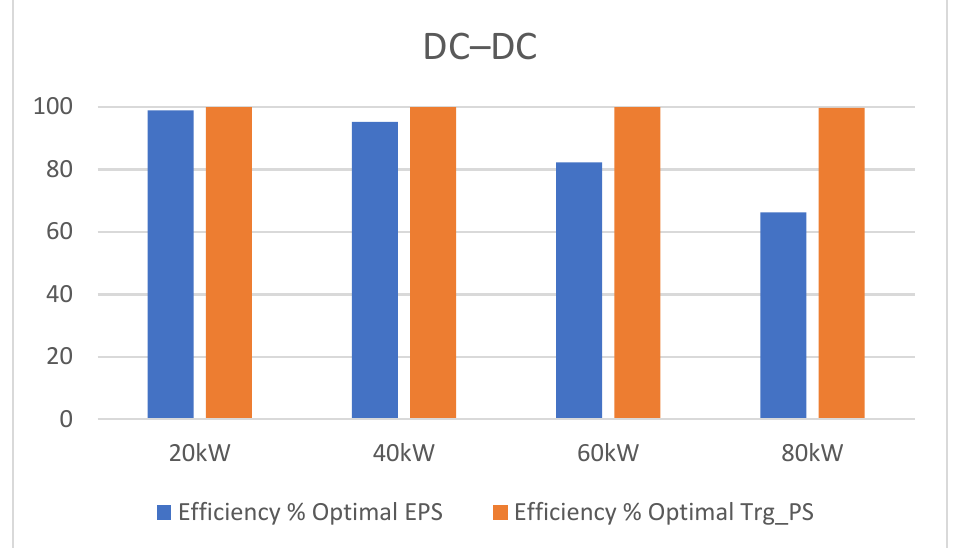
Figure 22. Efficiency of DAB DC-DC converter for different values of nominal power for operation under both optimal TrgPS and optimal EPS.